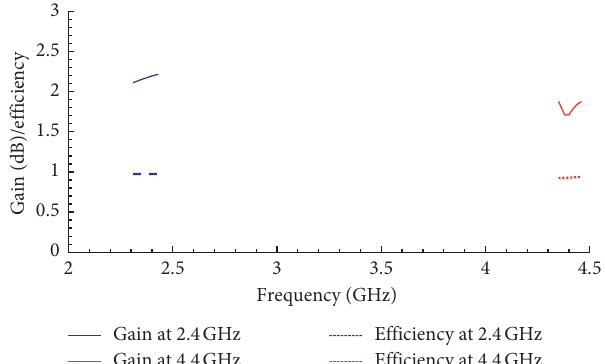
Figure 8: Gain and efficiency of the Carica papaya BioAs-MPA antenna.